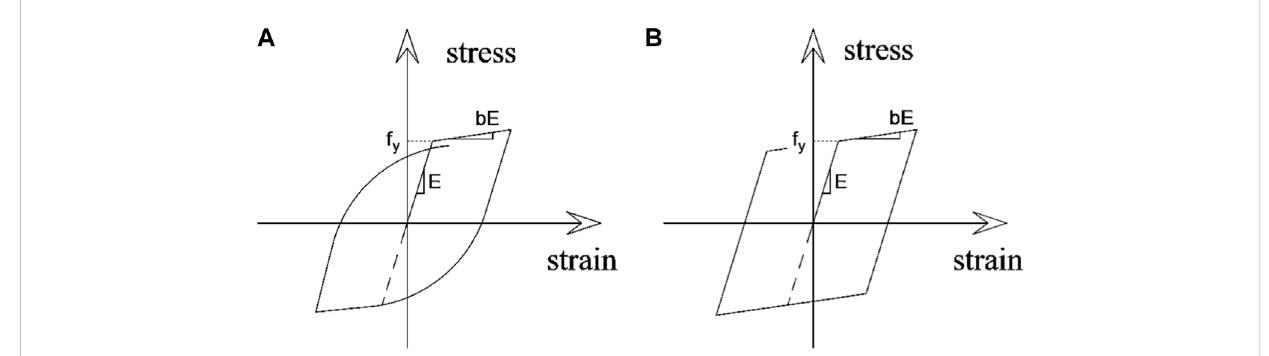
Frontiers in Built